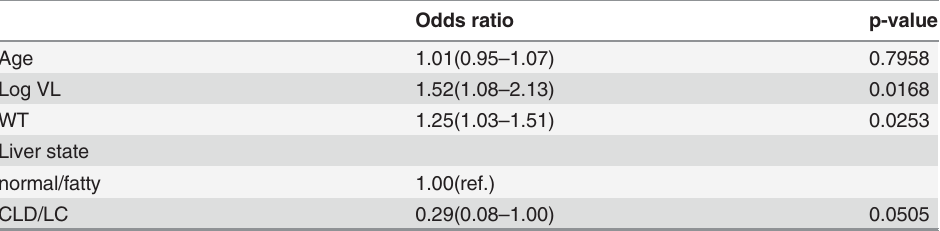
Table 3. The multiple logistic regression analysis for variables between HBeAg-positive and HBeAg-